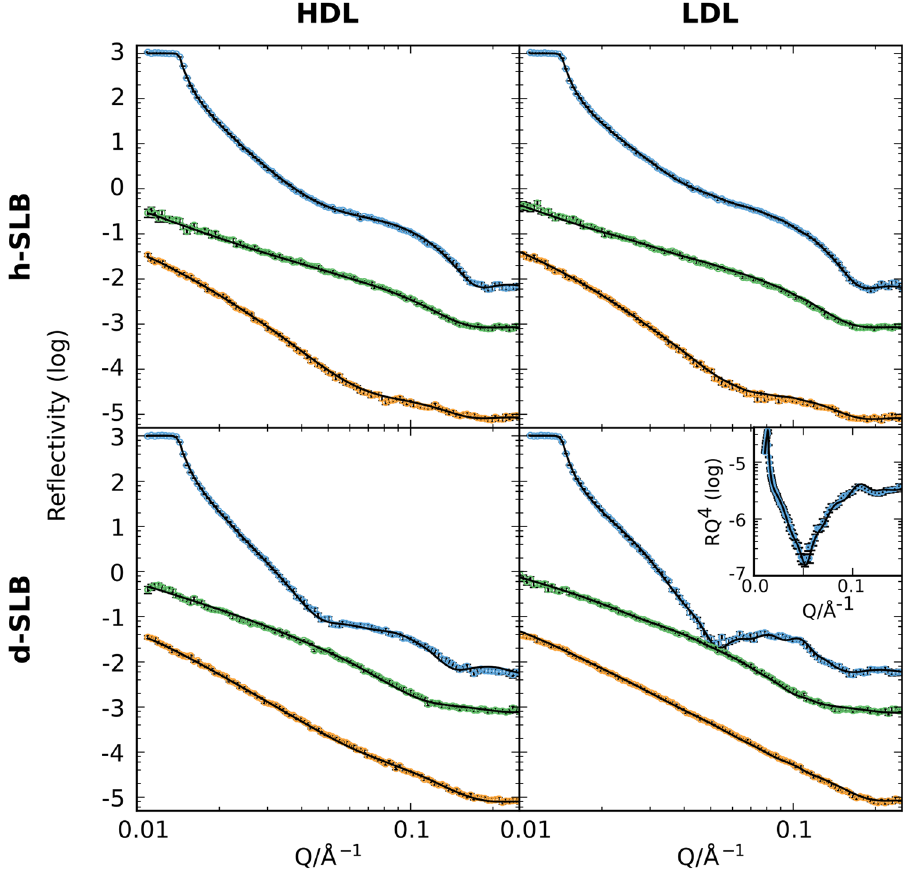
Figure 4. Experimental NR data (markers) and best fits (lines) after incubation for 8 hours with HDL (left) or LDL (right) on h- (upper row) or d- (lower row) SLBs made of DMPC/DMPS (90:10 mol%). The bulk contrasts are dTris buffer (blue), hTris buffer (yellow), and a solvent mixture with the same SLD as silicon (CMSi, green). For clarity, data for CMSi and dTris contrasts are offset by 10 and 100,